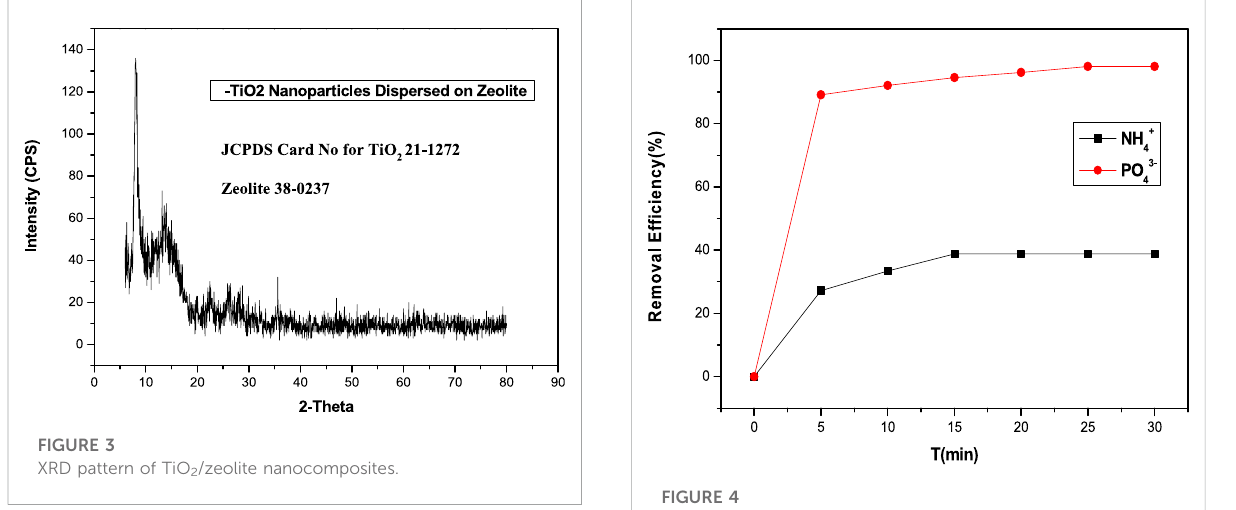
FIGURE 4 AdsorptionofphosphateandammoniumionsRequirements: C (PO 4 3- NH 4 + ) = 10 mg 100 ml − 1 ; 30 ° C; dosage 0.7 g 100 ml − 1 ; 30